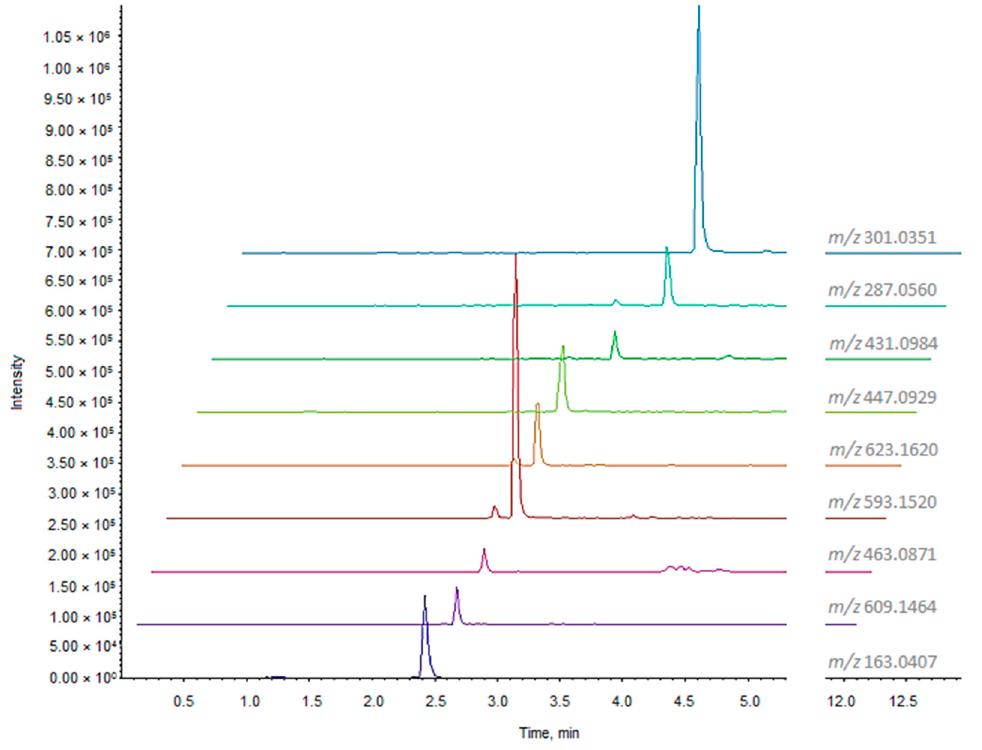
Figure 1. XIC chromatograms of phenols and polyphenols tentatively identified in ZLF-O fraction.